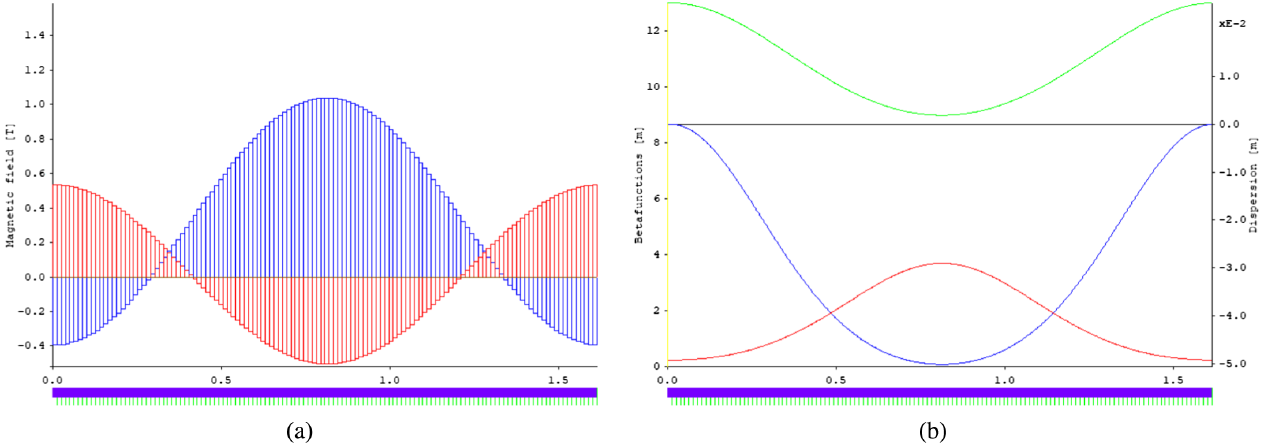
FIG. 15. Properties of the Mathieu cell for the SLS 2.0 example as computed by OPA . (a) Pole-tip fields for multipole slices (cf. Fig. 14). Only fields for multipoles of finite length (dipole: blue, quadrupole: red) are shown. (b) optical functions of optimized Mathieu cell for SLS 2.0 in opa ( β : blue, β : red, η : x y